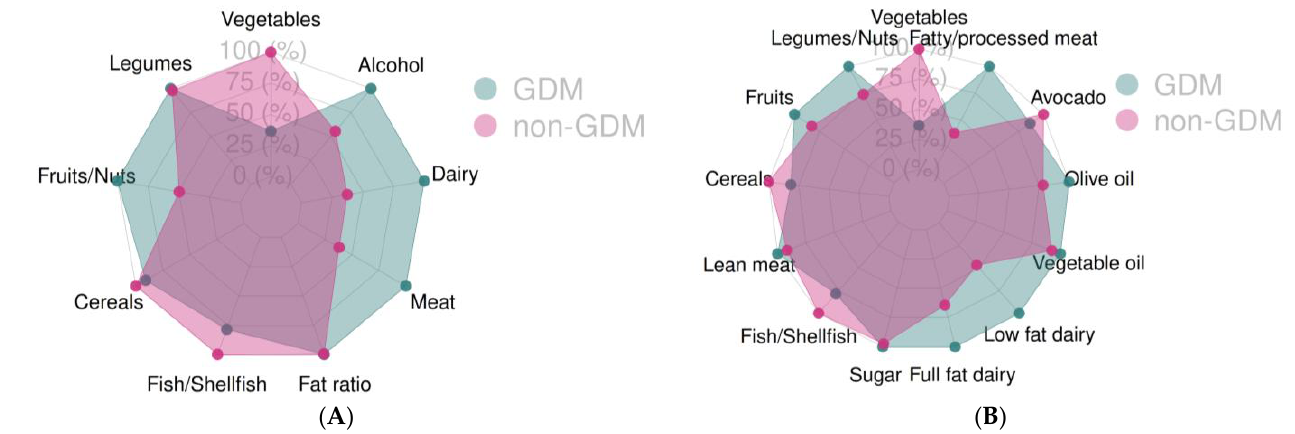
Figure 1. Food group adherence for the two groups, GDM and no GDM, using the Mediterranean Diet Score ( A ) and the modified Mediterranean Diet Score ( B ), GDM: Gestational Diabetes Mellitus. Table 2. Food group categories of the Mediterranean diet and mean consumption in the two groups, GDM and non GDM, based on the MDS.